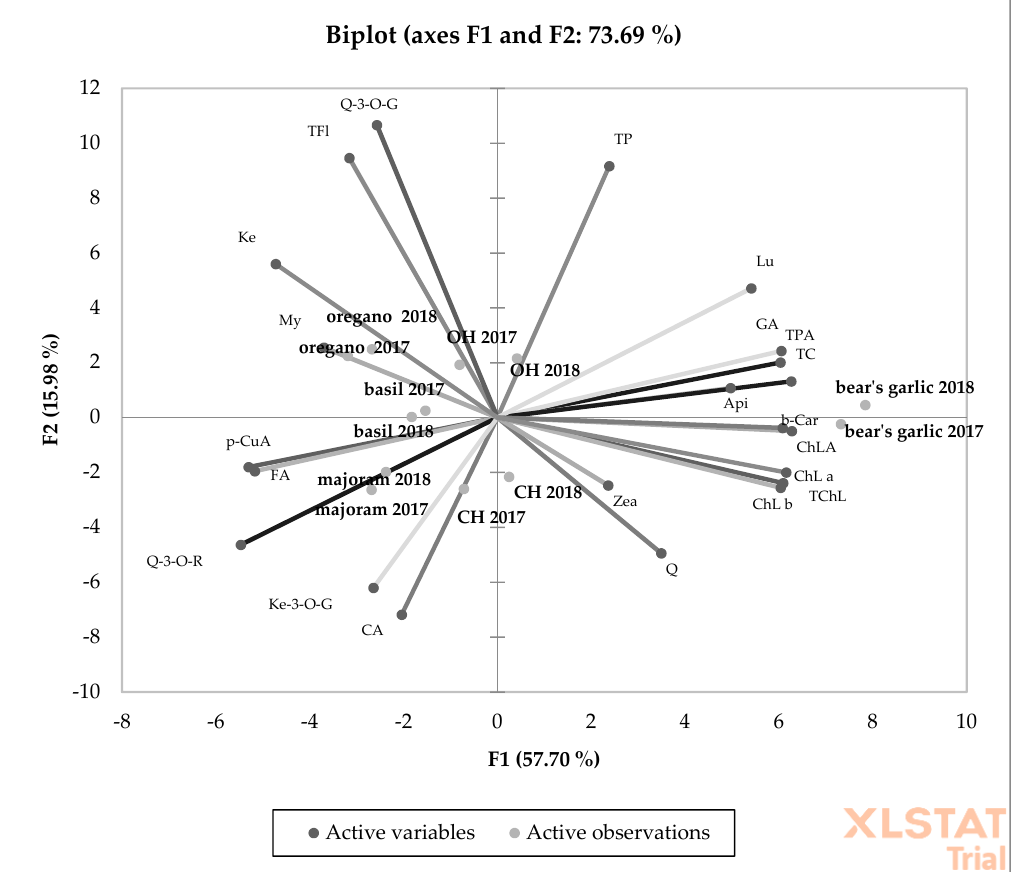
Figure 1. PCA analysis showing the relationship between the chemical composition and herbs origin (organic and conventional) as well species (oregano, basil, marjoram, and bear’s garlic) in two experimental years total polyphenols (TP), total phenolic acids (TPA), gallic acid (GA), chlorogenic acid (ChLA), caffeic acid (CA), p -coumaric acid (p-CuA), ferulic acid (FA), total flavonoids (TFl), quercetin-3- O -rutinoside (Q-3-O-R), kaempferol-3- O -glucoside (Ke-3-O-G), myricetin (My), quercetin (Q), quercetin-3- O -glucoside (Q-3-O-G), apigenin (Api), kaempferol (Ke), total carotenoids (TC), lutein (Lu), zeaxanthin (Zea), beta-carotene (b-Car), total chlorophylls (TChL), chlorophyll b (ChL b), and chlorophyll a (ChL a).